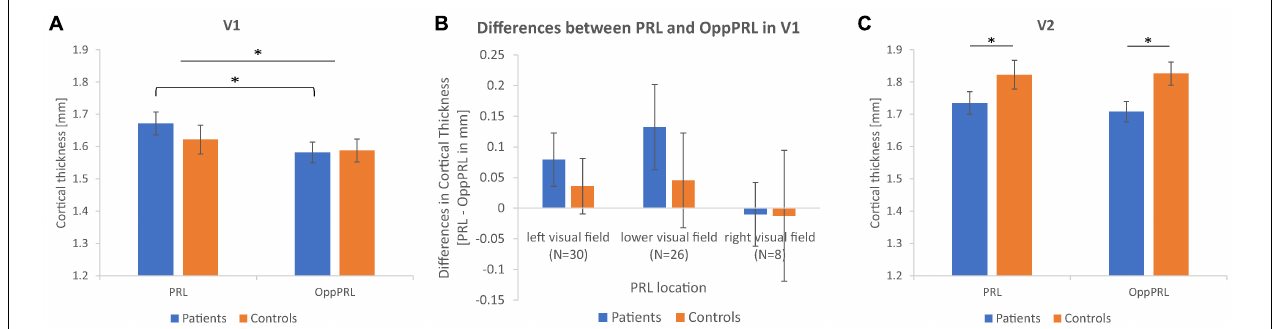
FIGURE 4 | Mean cortical thickness measures in mm together with their respective standard errors for the PRL and OppPRL regions in V1 (A) and V2 (C) . In V1, the repeated-measures ANOVA yielded a significant main effect of ROI, with greater CT values in PRL ROIs, that was more pronounced in the patient group, as post hoc tests revealed. In V2, the repeated-measures ANOVA yielded a significant main effect of group, with greater CT values in the control group independently from ROI. (B) Shows the mean differences in CT between PRL and OppPRL ROIs plotted separately for the three PRL location clusters in the left, lower and right visual field (see also Figure 1C ) together with their respective standard errors ( ∗ p < 0.05).